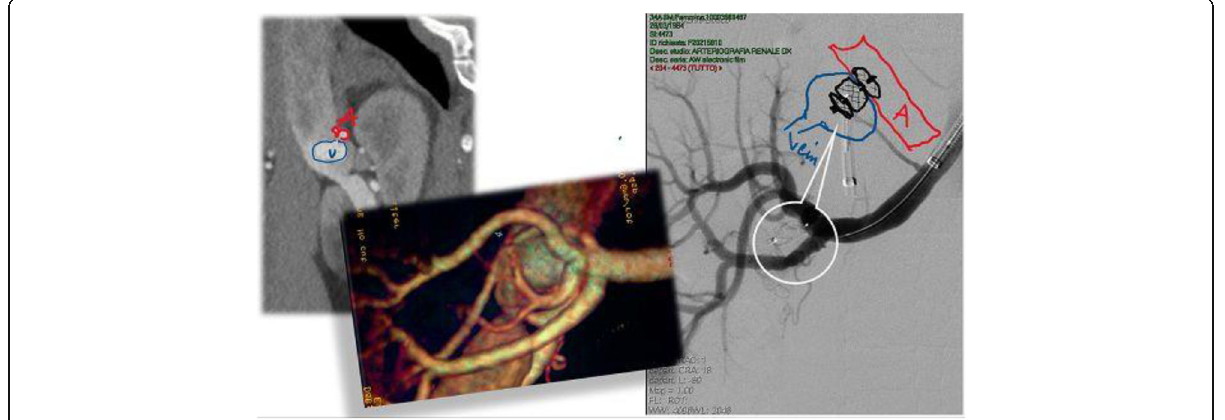
Fig. 2 Left: CT and VR view of the communication point of the CRAVF. Right: Amplatzer Vascular Plug II released at extact level of the arteriovenous comunication